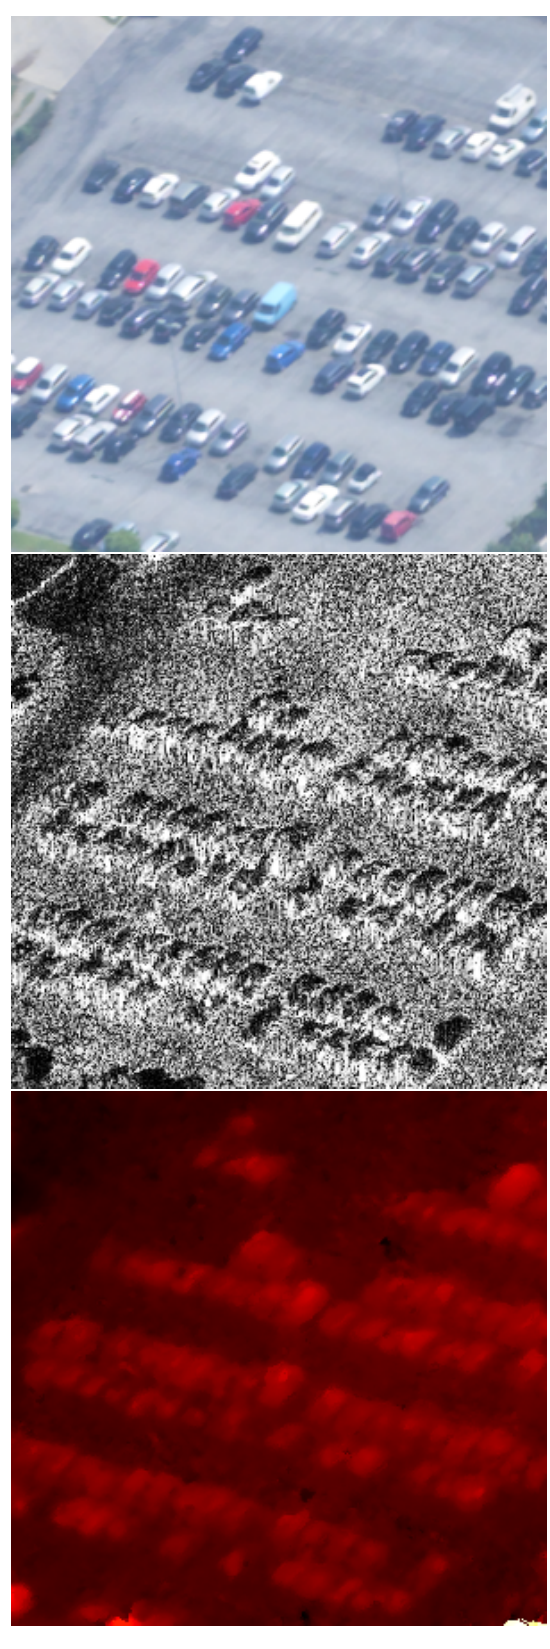
Figure 2. Top: RGB image. Middle: SAR image, projected in RGB view. Bottom: Elevation map of the used DSM ranging from 429m (black) over red and yellow to 432m (white), projected into optical camera